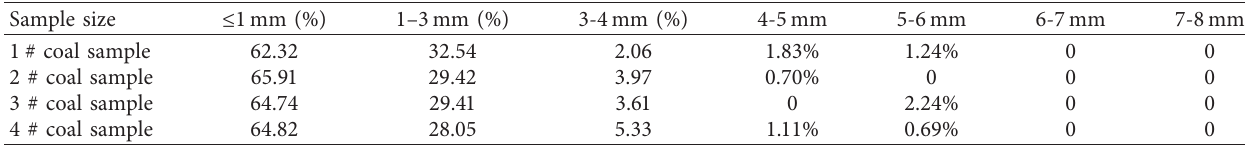
Figure 7: The relationship between the pressure characteristics and the particle size. (a) Duration of sample outburst stage and stable conveying stage. (b) Extreme pressure of 1 # sensor and 8 # sensor. Table 2: Particle size distribution after the mixed coal sample